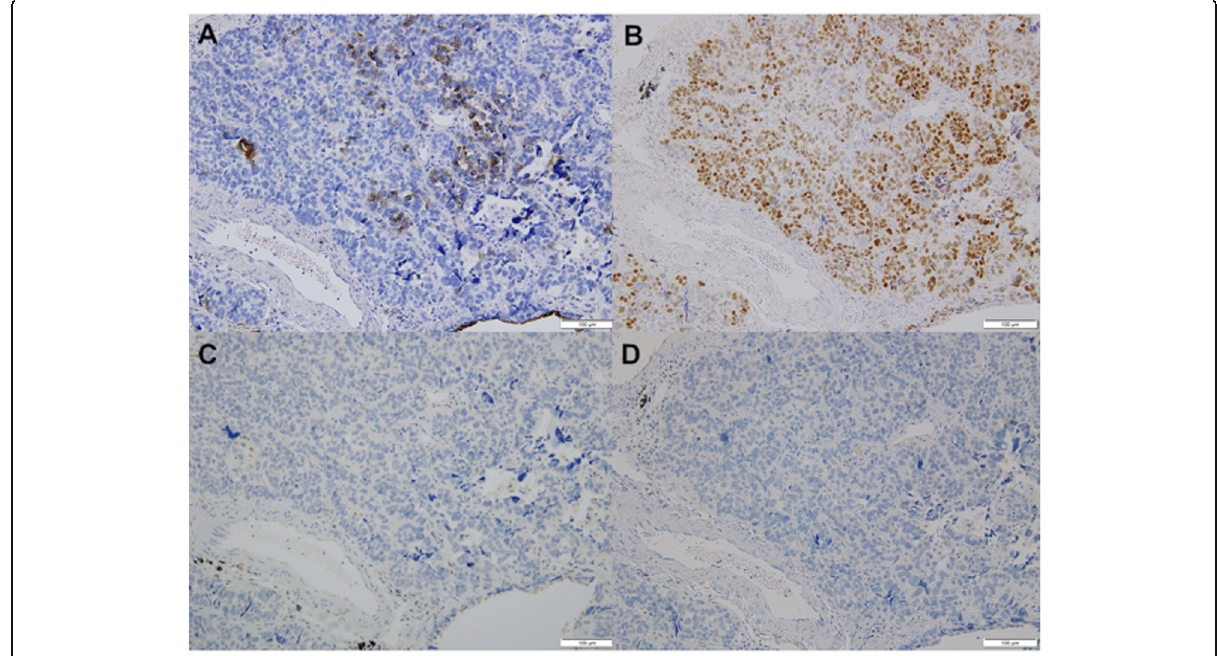
Fig. 3 Results of an immunohistochemical analysis of the pulmonary disease. a EMA, b AR, c p53, d Ber-EP4 (magnification ×